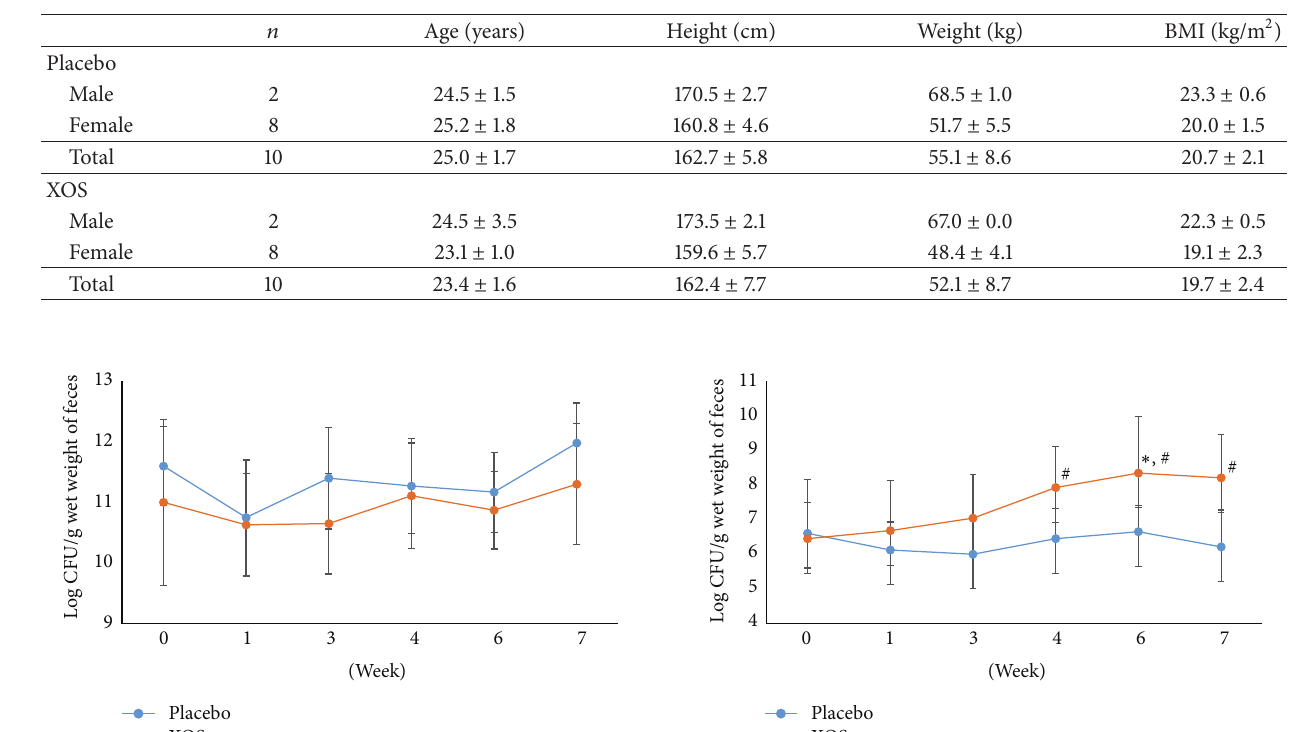
Table 1: Basic characteristics of subjects.